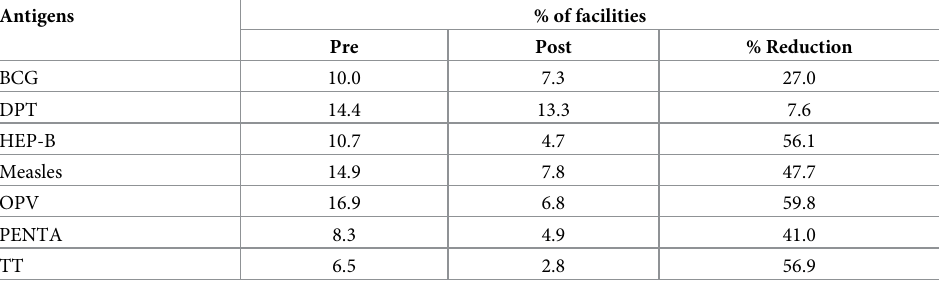
Table 4. Facilities reporting stock-out of antigens.